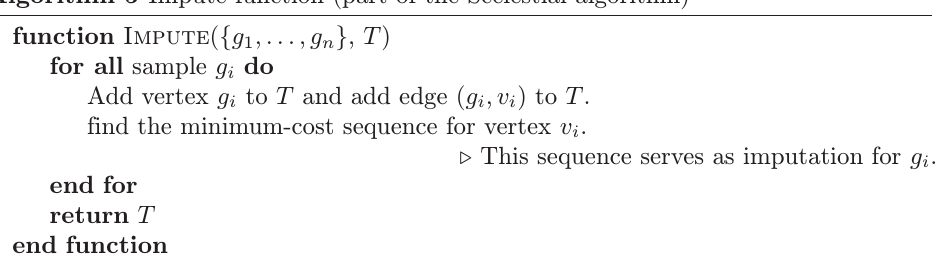
Algorithm 5 Impute function (part of the Scelestial